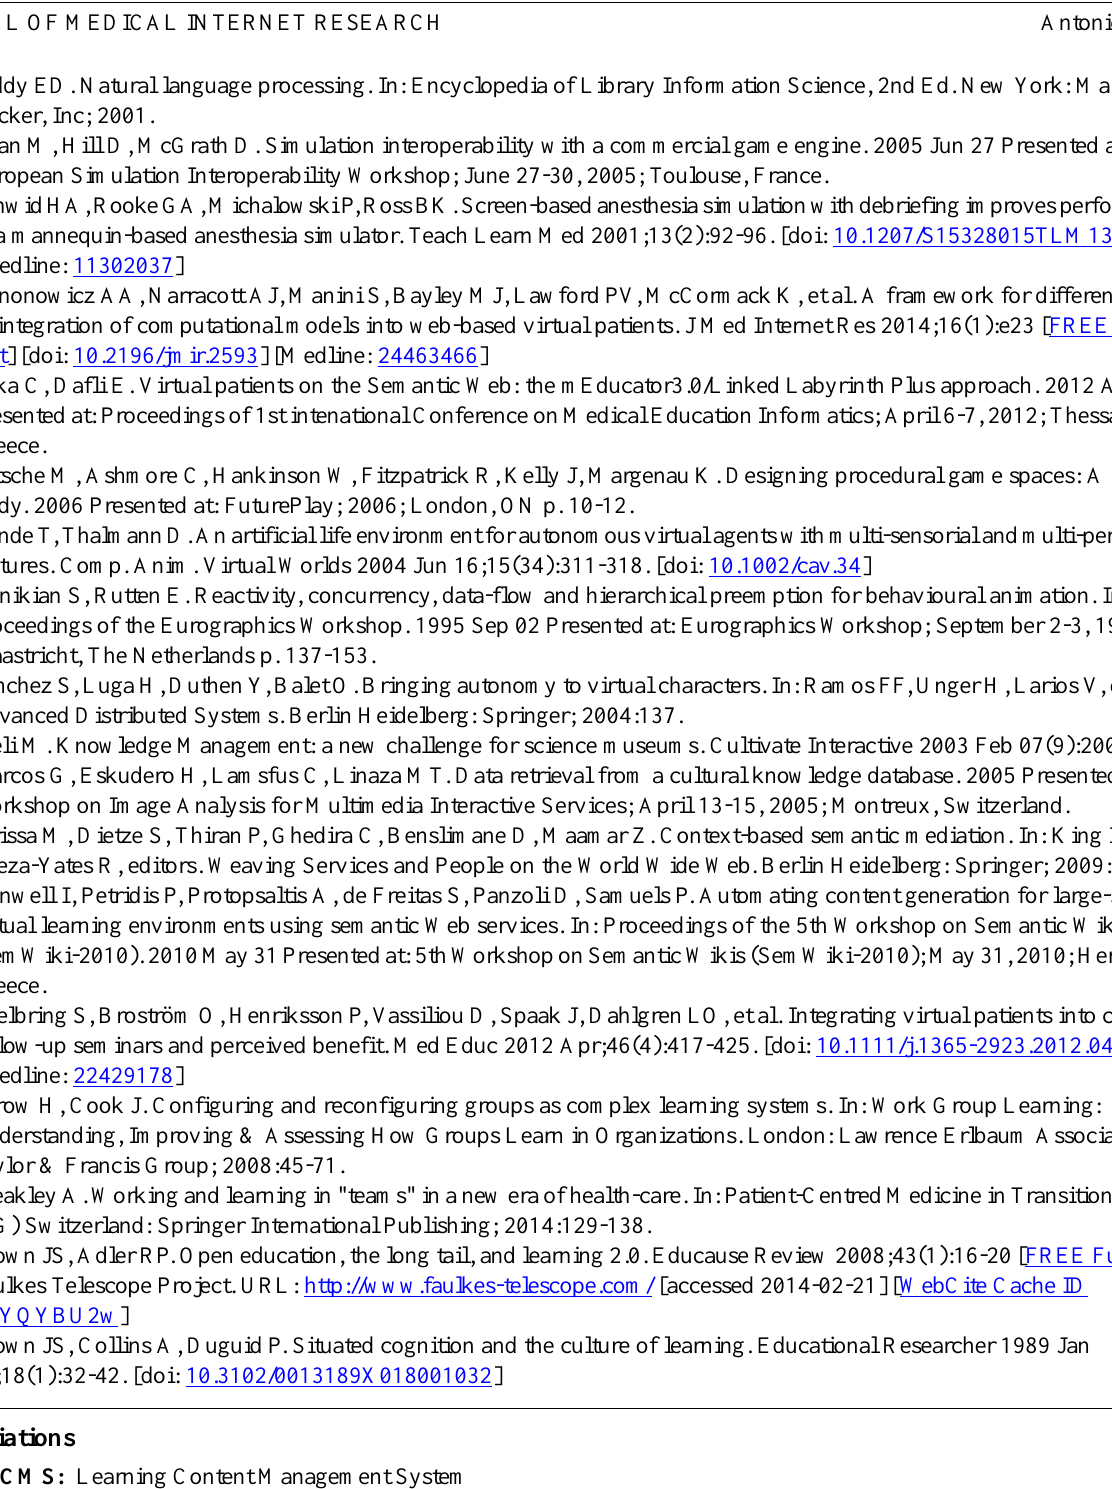
LCMS: Learning Content Management System LOM: Learning Object Metadata LSL: Linden Scripting Language MMOG: massive multiplayer online game MMORPG: massive multiplayer online role-playing game MUVE: multi-user virtual environment SCORM: Sharable Content Object Reference